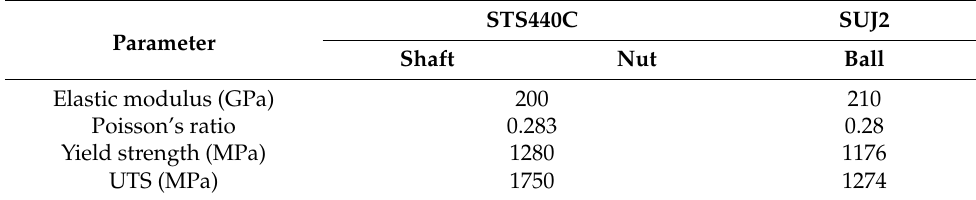
Table 2. Material properties.